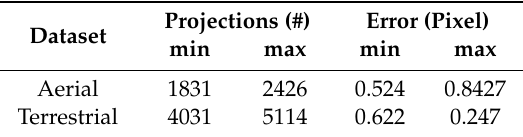
Table 3. Report on image matching for the two